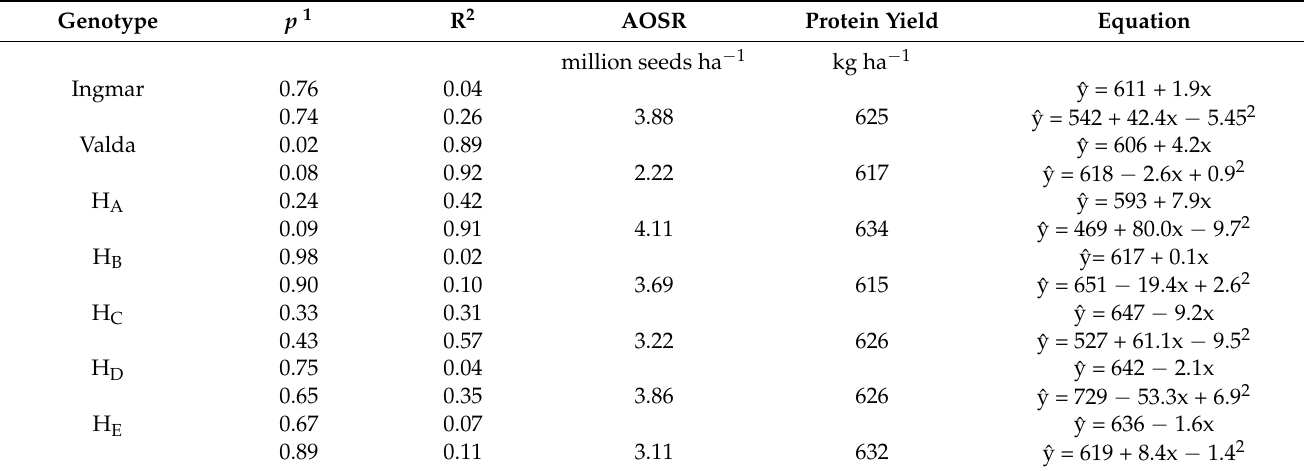
Table 9. Linear and quadratic regression analysis for HRSW protein yield response averaged across seeding rate for eight environments in North Dakota,